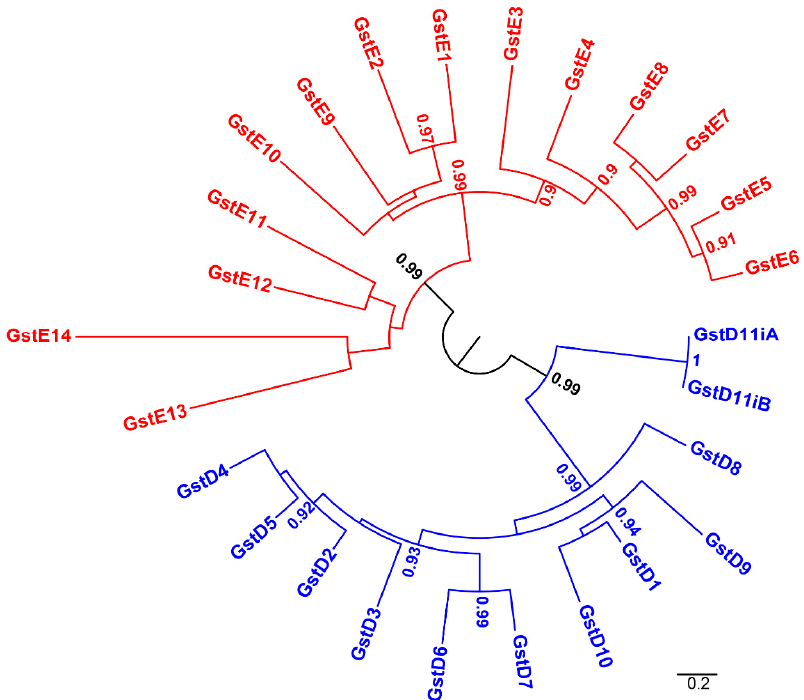
Figure 2. Evolutionary relationships of Delta and Epsilon GSTs of Drosophila melanogaster . Phylogeny was created from full-length protein sequences applying the maximum likelihood method [21]. Dots represent branch support values based on the fast likelihood method, aLRT ≥ 0.9; aLRT < 0.9 were discarded (aLRT corresponds to the approximate Likelihood-Ratio Test). The branch length corresponds to the number of amino acid substitutions, and the scale bar indicates the average number of amino acid substitutions per residue. Delta and Epsilon GST are represented in blue and red, respectively.